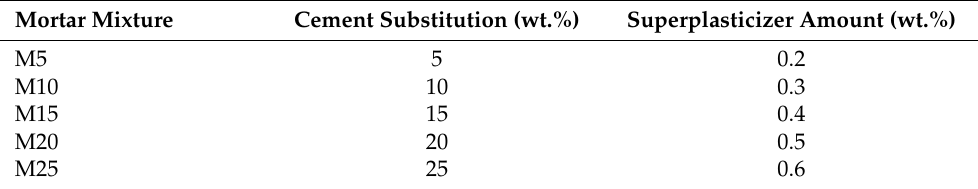
Table 3. Mortar mixture